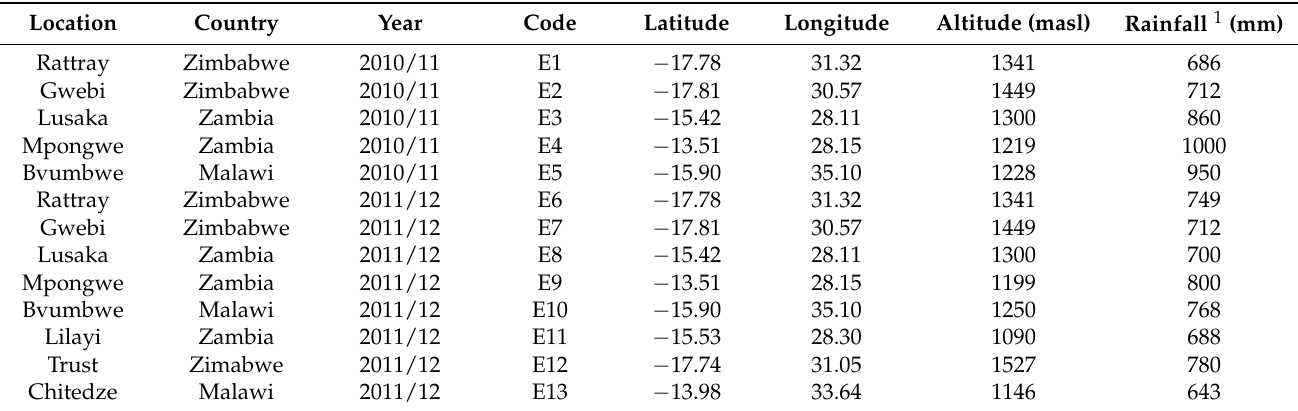
Table 2. Physical and weather characteristics of the study